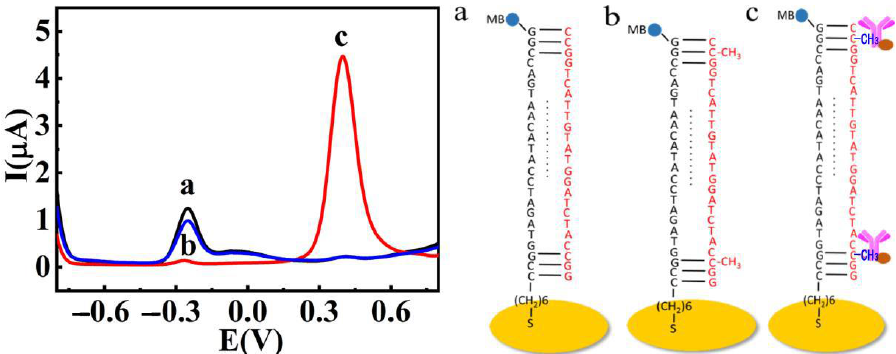
Figure 1. SWV responses of the developed biosensor at different experimental conditions: ( a ) H1/H2/GE, ( b ) methylated H1/H2/GE, and ( c )